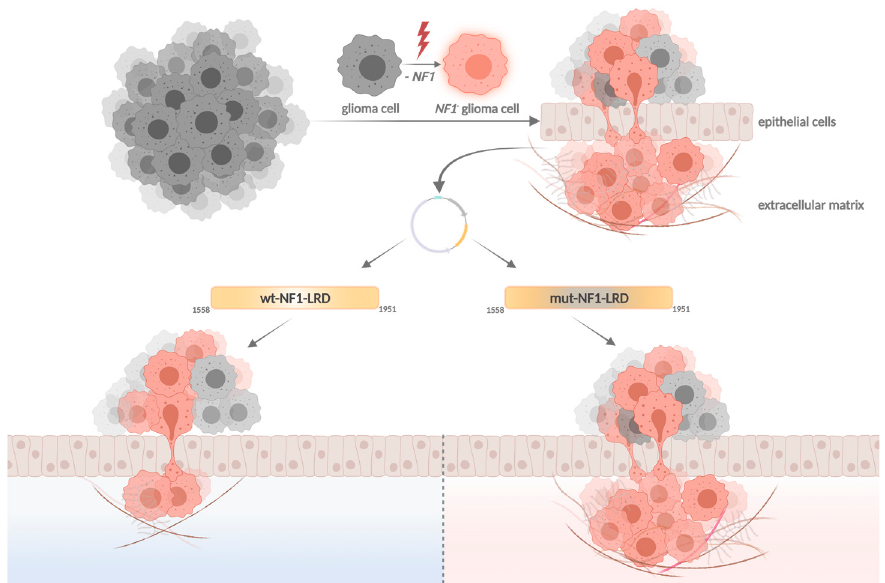
Figure 7. NF1 alteration of the leucine-rich domain (LRD) of neurofibromin promotes glioma inva- siveness. Created with BioRender (UE233WMPOB, 23 October 2021). invasiveness. Created with BioRender (UE233WMPOB, 23 October